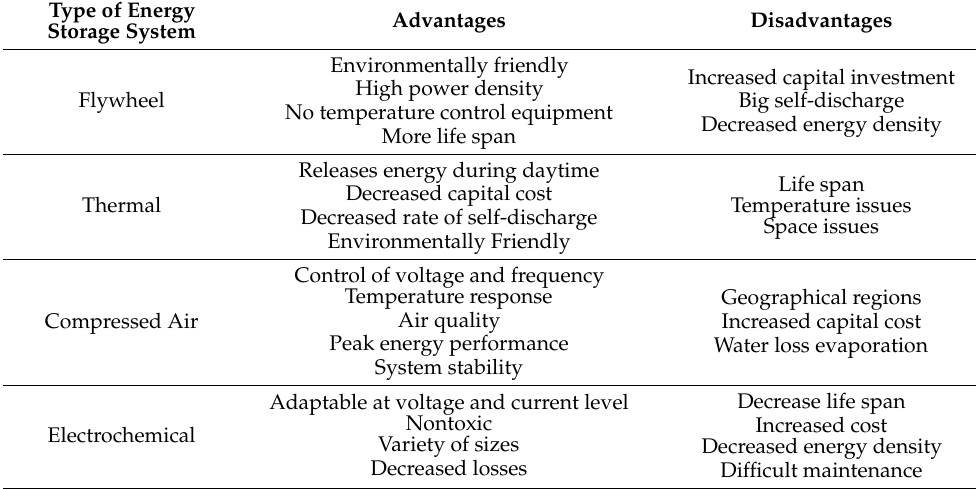
Table 4. Synopsis of available ESS